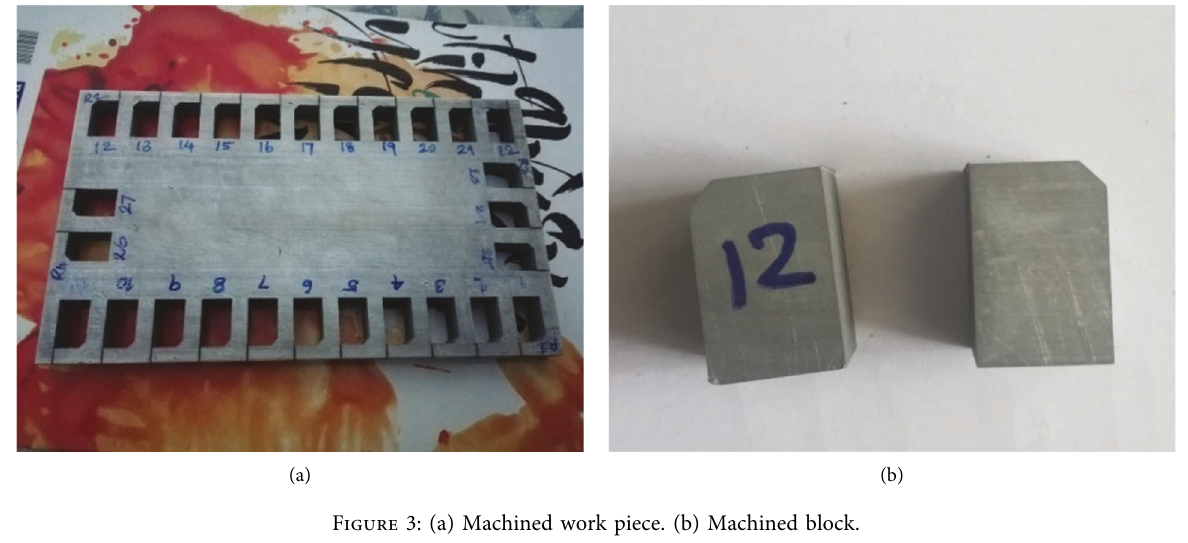
Figure 3: (a) Machined work piece. (b) Machined block.